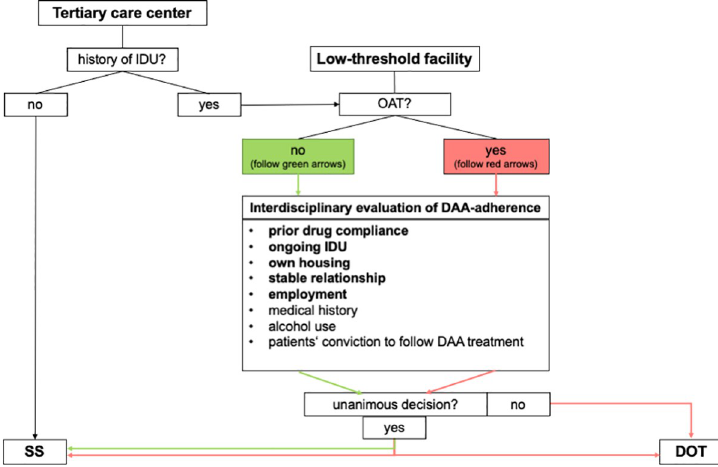
Fig 1. Flowchart describing the process of assigning patients to the directly observed therapy-group (DOT) or "standard setting" (SS). Abbreviations: IDU, intravenous drug use; OAT, opioid agonist therapy; DAA, direct acting antivirals; SS, standard setting; DOT, directly observed therapy. Patients without a history of intravenous drug use (IDU) presenting at the tertiary care center were assigned to the SS-group. Also, patients with a history of IDU and presumed excellent compliance concerning adherence to DAA-therapy presenting at the tertiary care center or at the low-threshold facility were treated according to the SS. Patients on OAT with presumed high risk of non-adherence to DAA-therapy according to a unanimous decision between the members of the interdisciplinary evaluation team were assigned to the DOT-group. In case of different opinions among the evaluation team members concerning patients’ presumed compliance, the DOT setting was